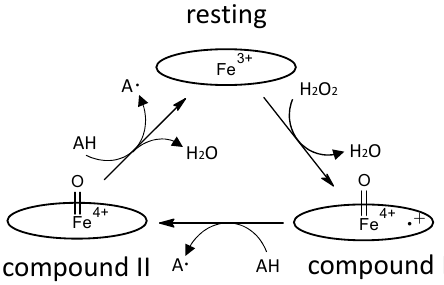
Figure 2. Catalytic cycle of a typical heme peroxidase. Oval denotes the heme plane in the enzyme. AH is a substrate.